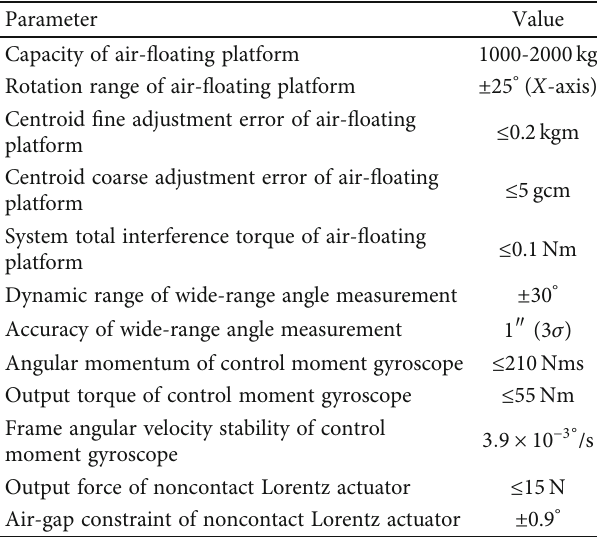
Figure 4: Physical system of the noncontact close-proximity formation satellite. Table 1: Related parameters of physical system